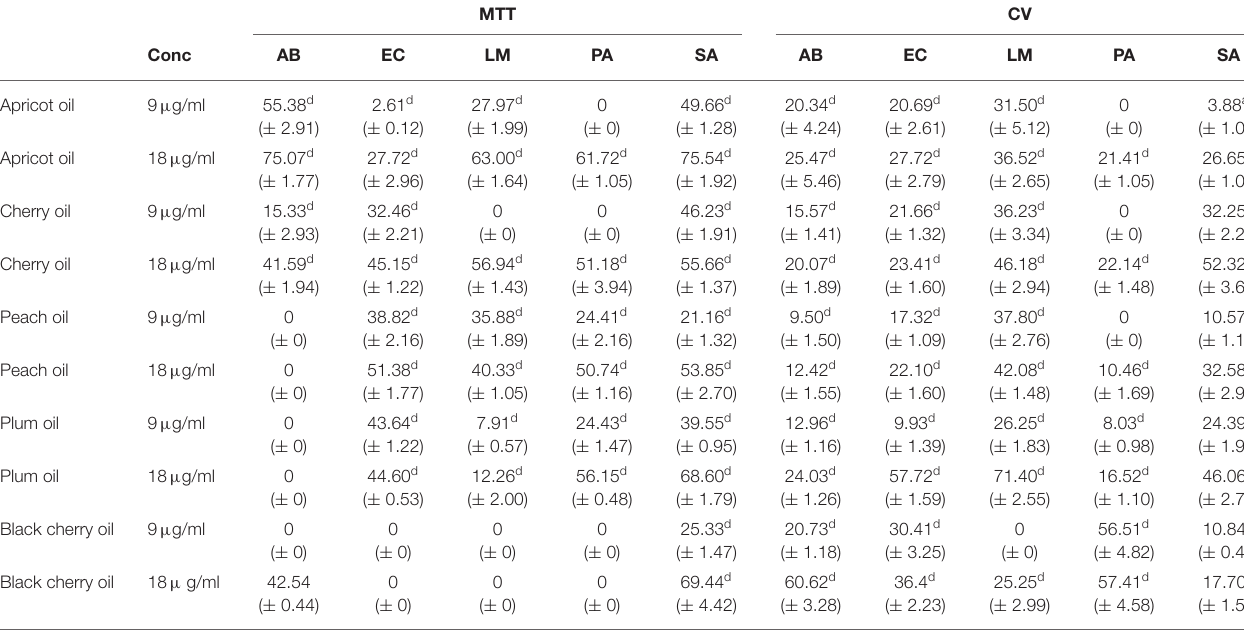
TABLE 6 | Inhibitory activity of the cold-pressed seed oils of apricot, cherry, peach, plum, and black cherry, tested at 9 and 18 µ g/ml, on the biofilm formation capacity of the five pathogenic strains.